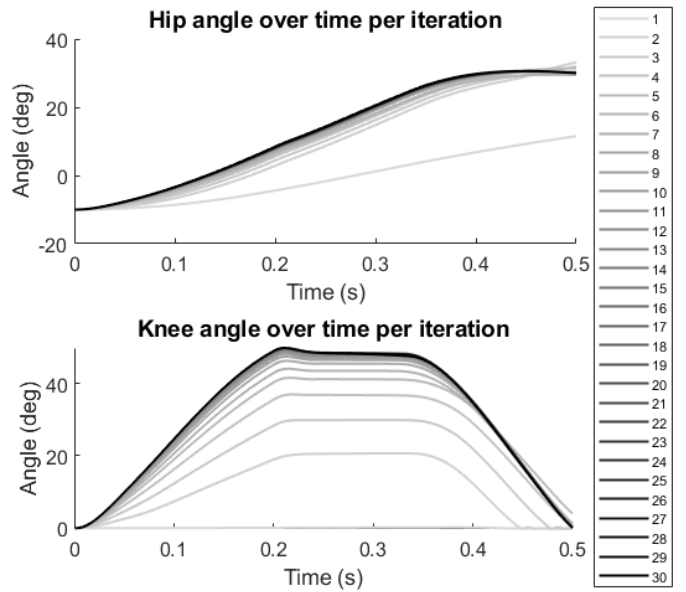
Figure 3. Joint angle progression as the controller updates inputs with each successive swing phase. The line becomes darker to indicate progressive iterations.